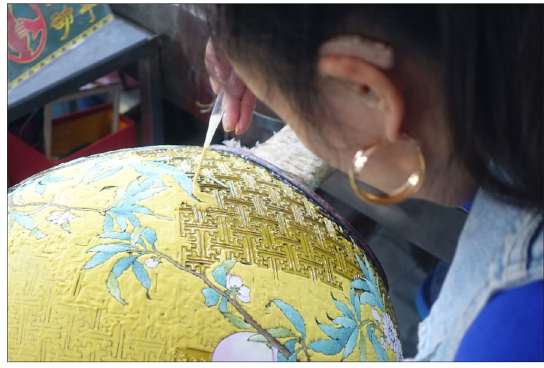
Fig. 9 Beijing Enamel Factory Co.